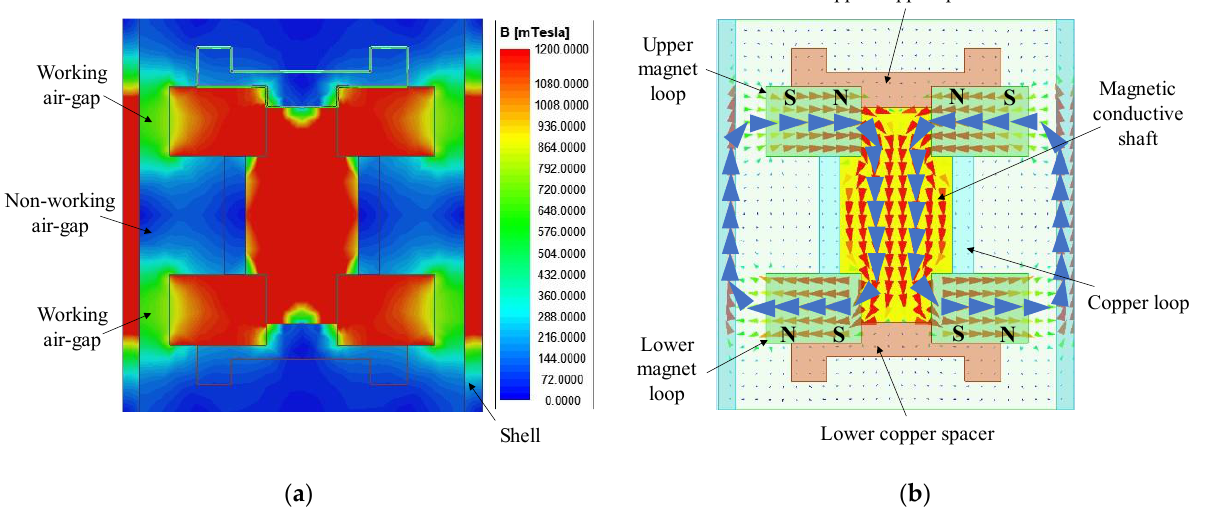
Figure 10. Magnetic field distribution inside the DM sensor. ( a ) Cloud diagram that reflects the in- tensity of magnetic field; ( b ) vector diagram that indicates the direction of magnet loop.